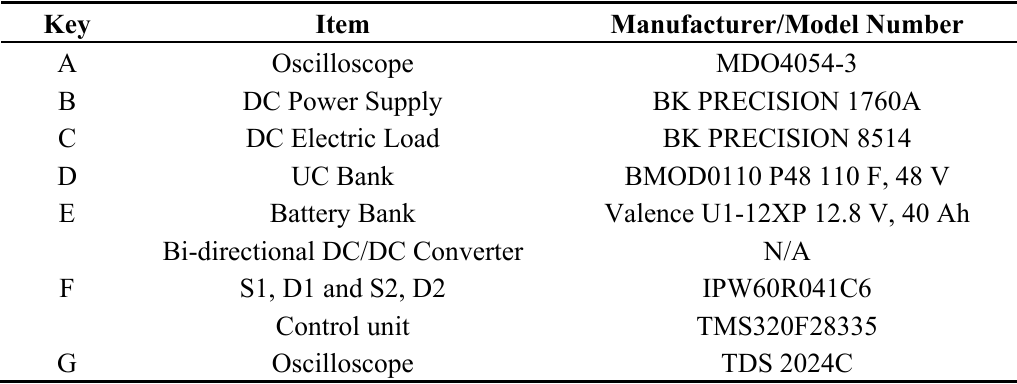
Table 6. Equipment used in the test